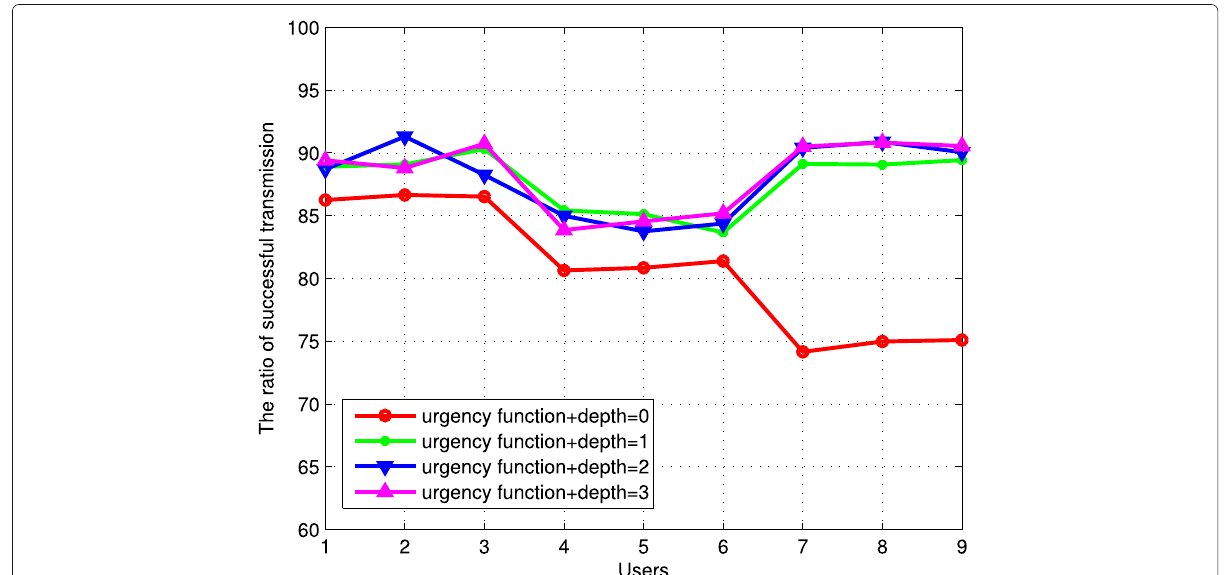
Fig. 5 Successful transmission of nine devices referring to different k . The figure shows the successful transmission ratio when different depth k are used in the emergency function